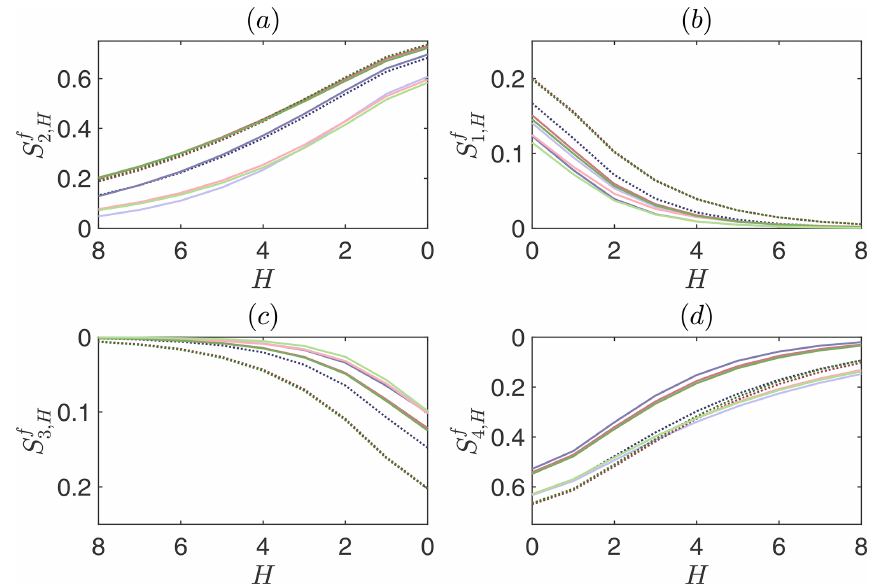
Figure 7. Stress fractions at z/h ≈ 0 . 1. The profiles are normalized so that the sum of the stress fractions for H = 0 is unity across the cases. Lines are defined in Fig. 1.